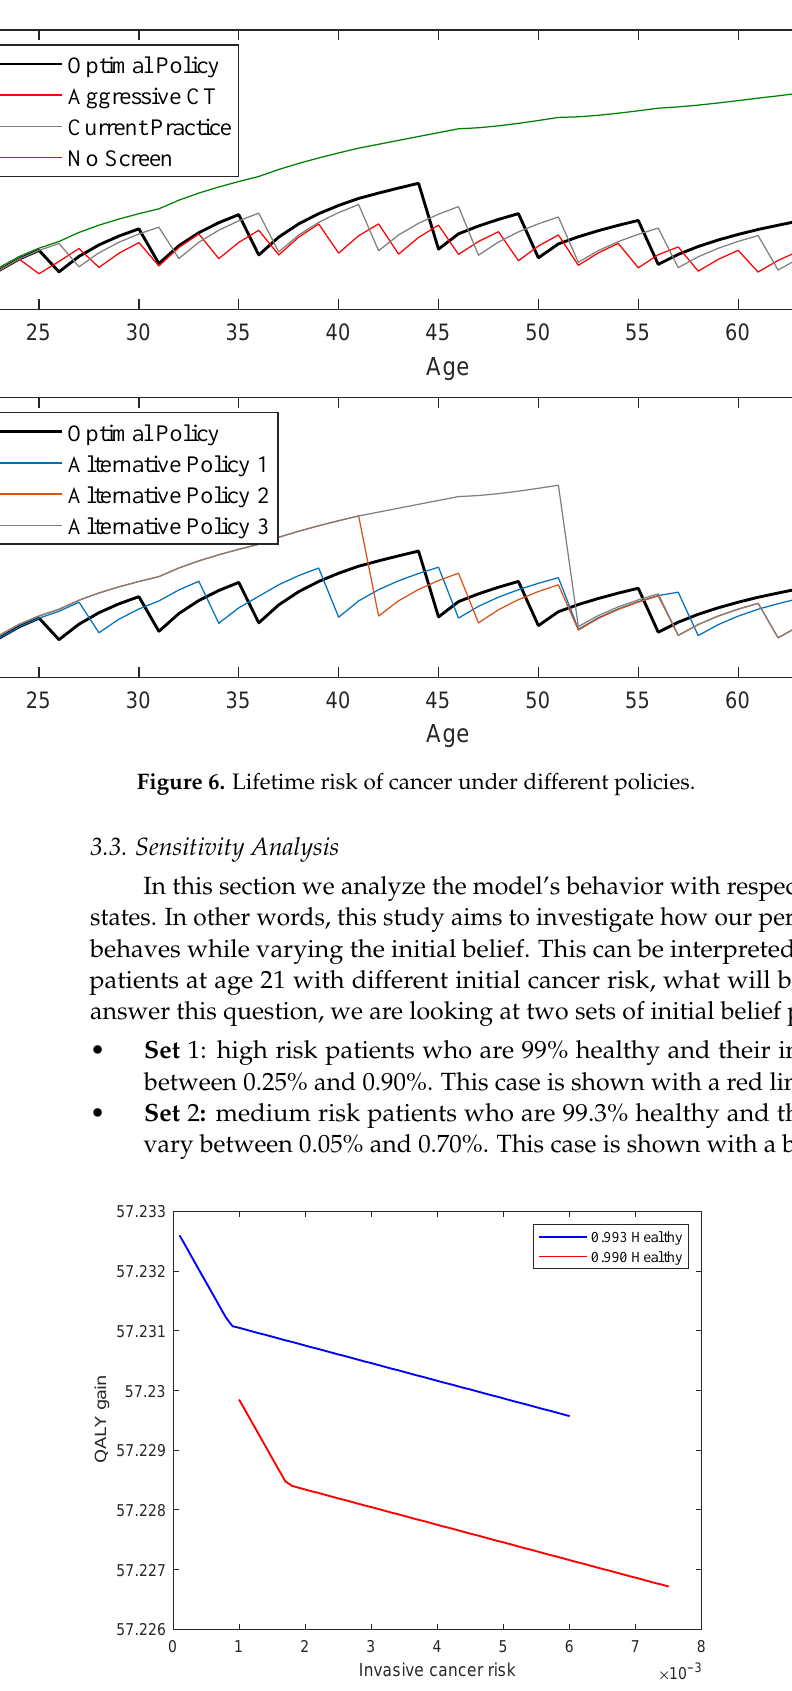
Figure 7. Quality adjusted life years (QALY) gained under different starting belief